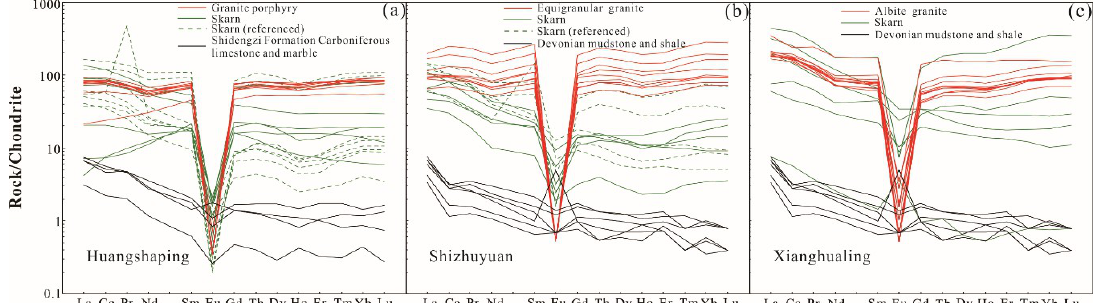
Figure 9. Chondrite-normalized REE patterns for granites, strata and skarns of the ( a ) Huangshaping, ( b ) Shizhuyuan and ( c ) Xianghualing deposits. Data sources are the same as in Figure 8. Normalized values for chondrite are from [78].